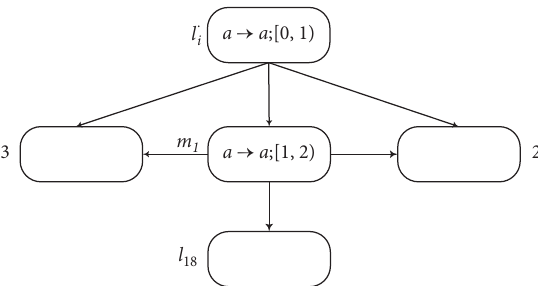
Figure 14: Module ADD-ADD: simulating ADD-ADD instructions l